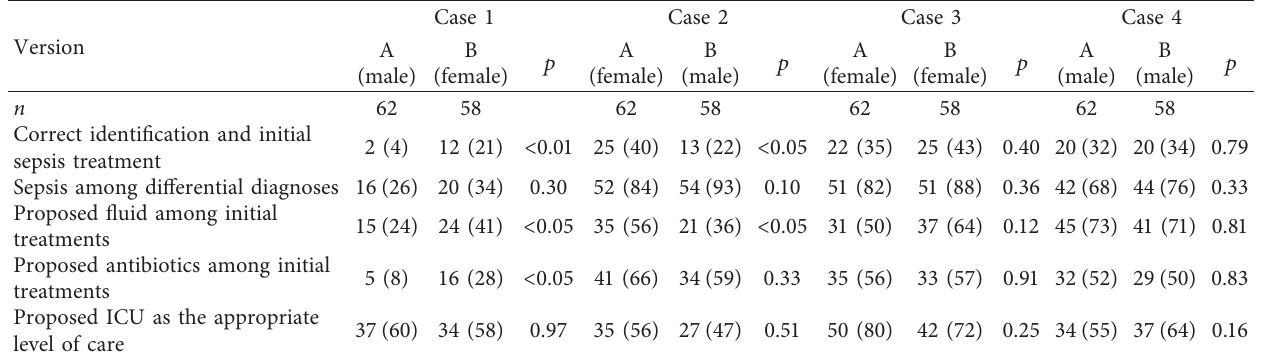
Table 2: Distribution of the participants’ answers to the two versions of the